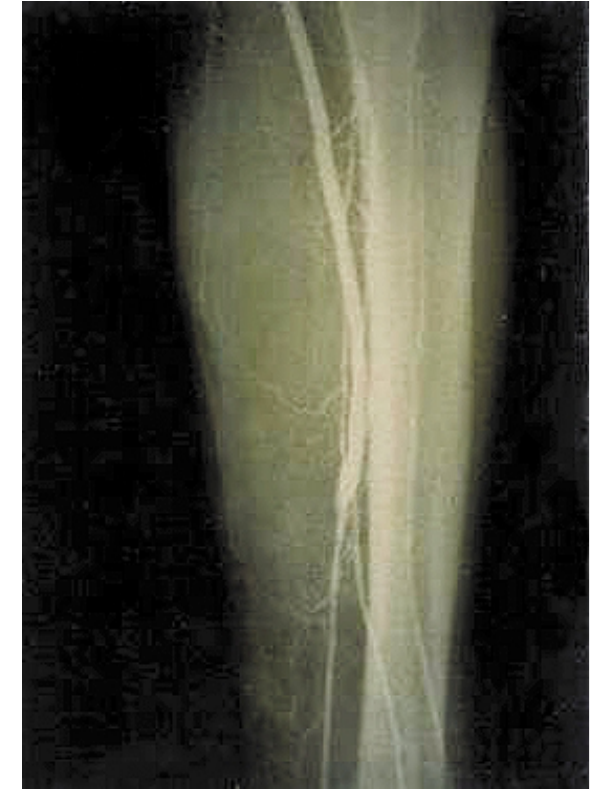
FIGURA 1 - Derivação femoro-fibular.